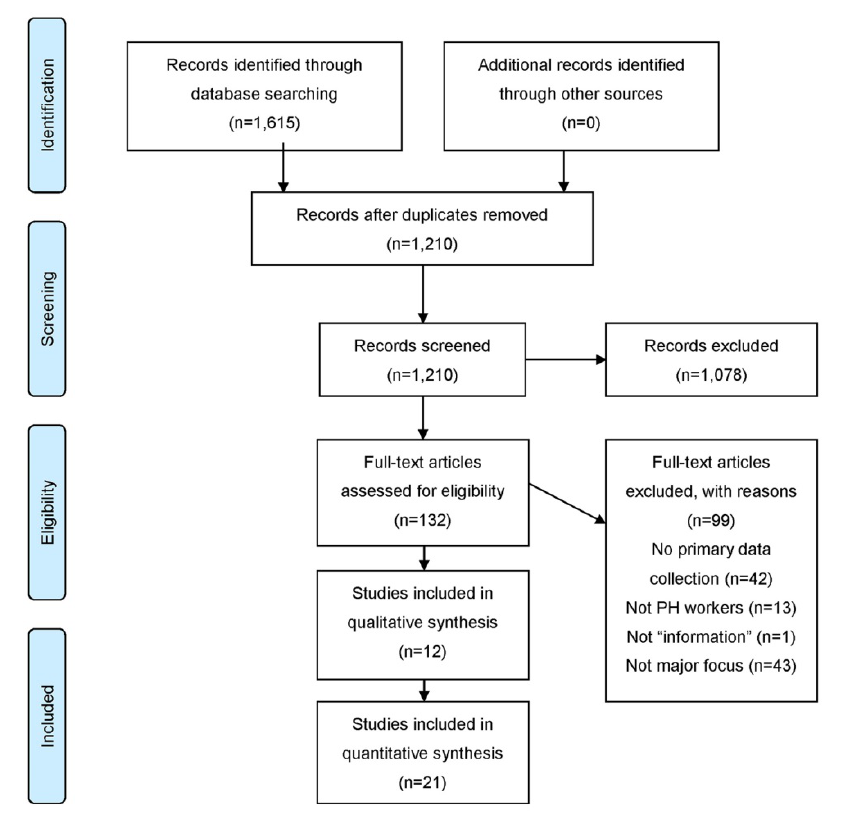
Figure 1 PRISMA flow diagram